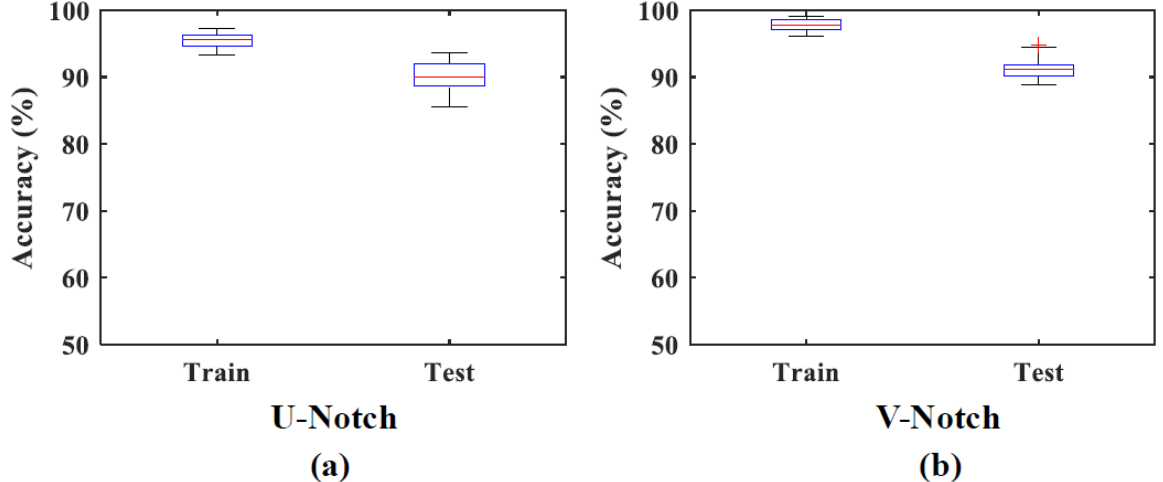
Figure 18. Average training and testing accuracy across all hold-out-based validation iterations for ( a ) U-notched and ( b ) V-notched specimens in the CP > 1 mm regime. The red lines denote the medians of the distributions.